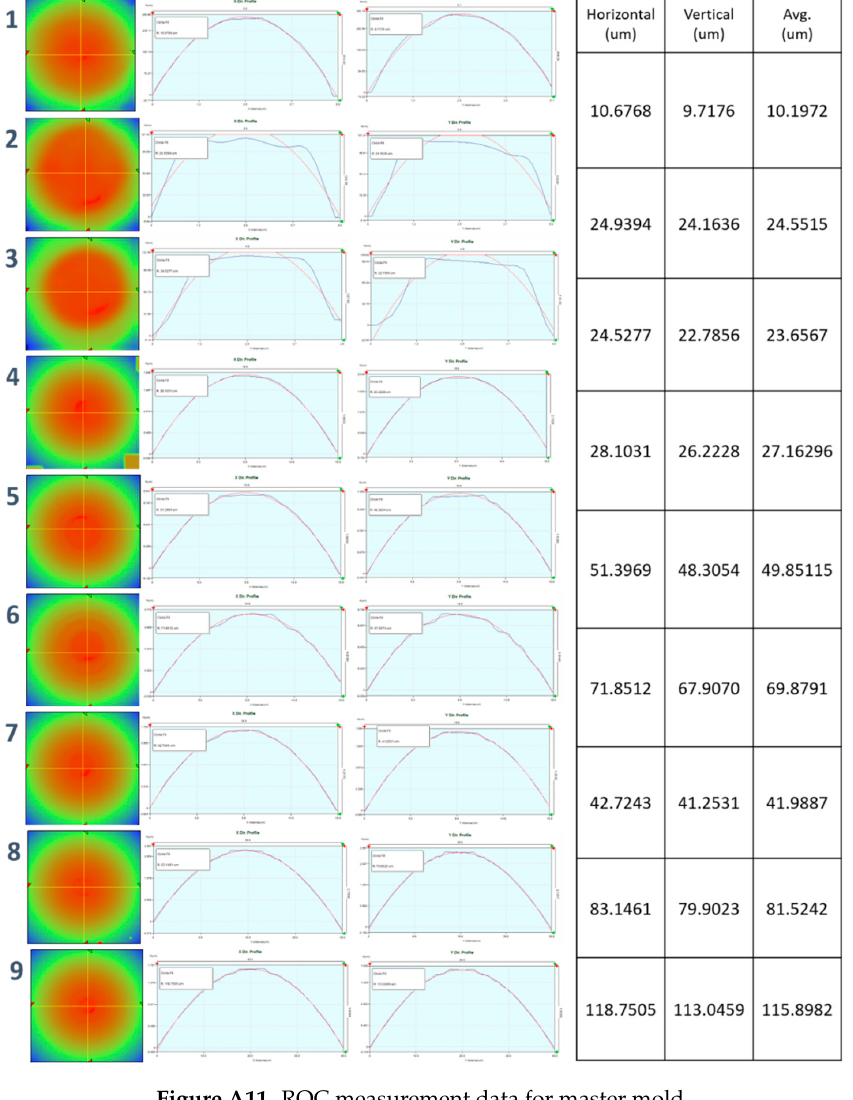
Figure A11. ROC measurement data for master mold.